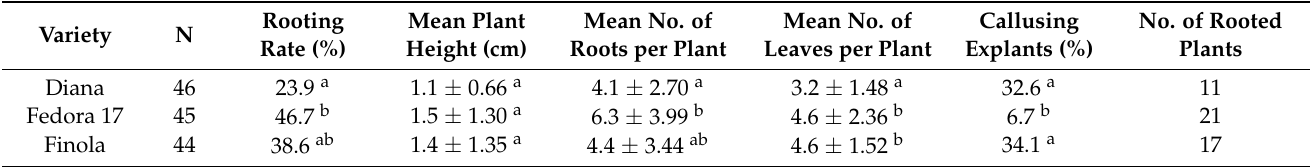
Table 7. Effect of genotype on rooting rate, mean number of roots and leaves per shoot, and callusing rate after three weeks of culture on rooting